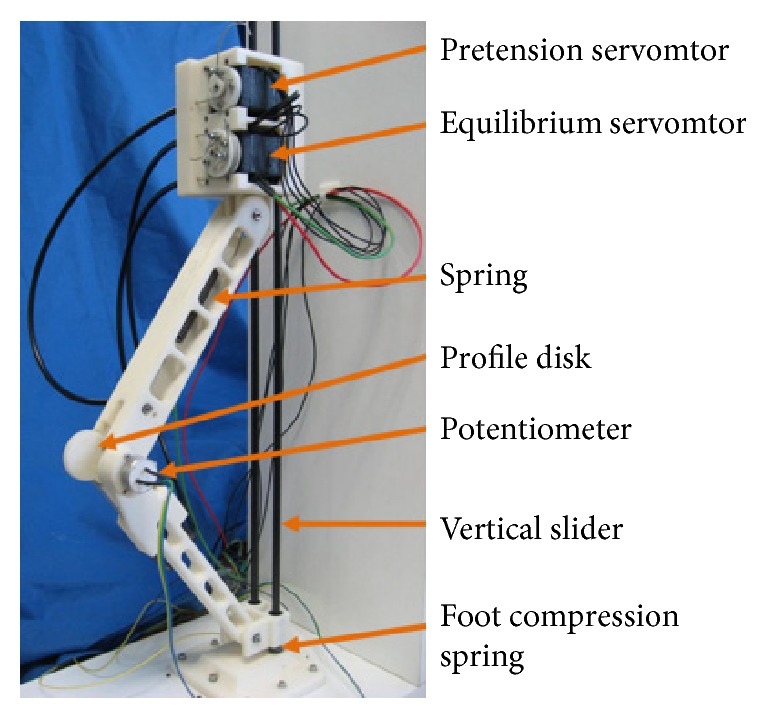
Jumping robot Chobino1D [38].